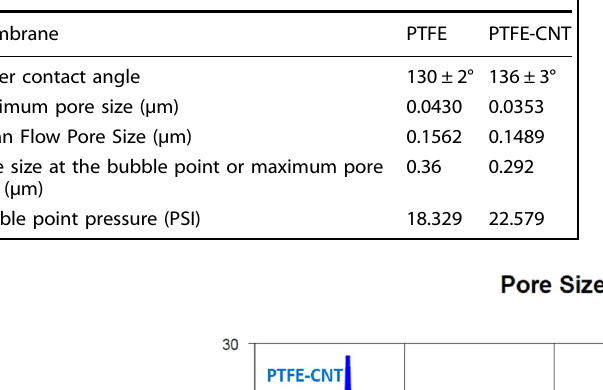
Table 1. Water contact angle and pore size distribution data of PTFE and PTFE-CNT membranes.